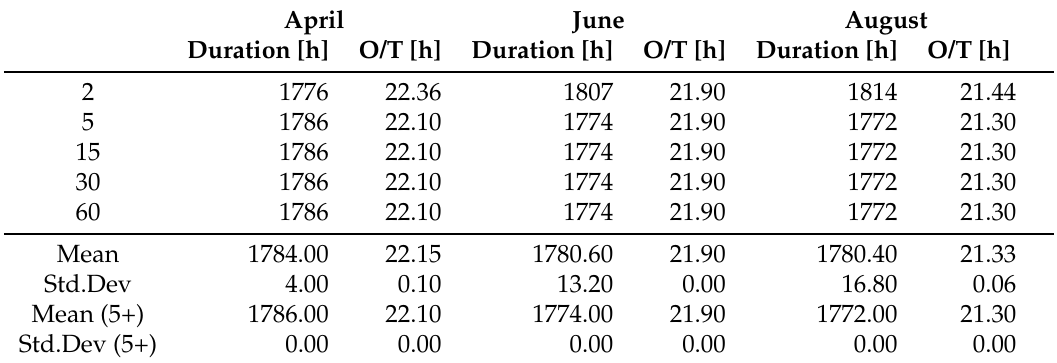
Table 7. Results of different optimization times for a single vessel.